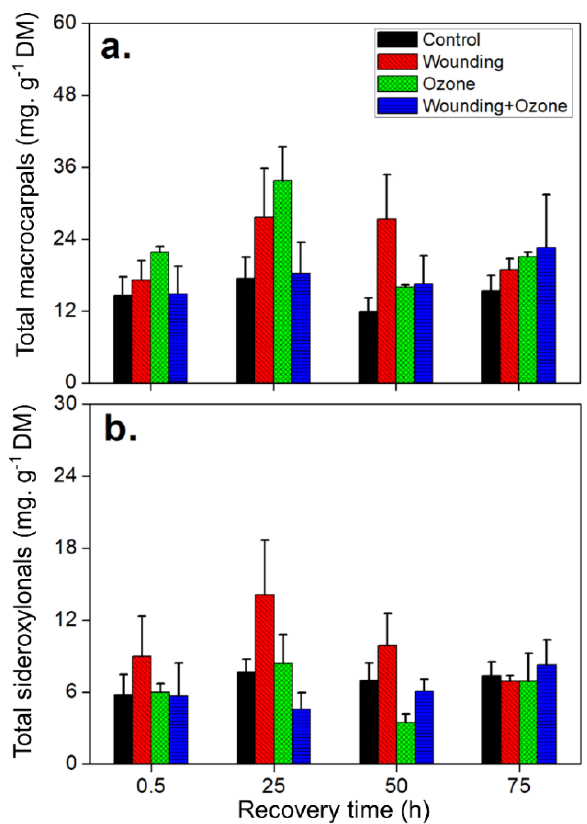
Figure 5. Time-dependent changes (means ± SE, n = 3) in the concentration of total macrocarpals ( a ) and total sideroxylonals ( b ) in E. globulus leaves subjected to separate and combined wounding and O 3 treatments. Details of the statistical summary are shown in Table 3. Total macrocarpals are expressed as mg g − 1 DM macrocarpal A equivalents, and total sideroxylonals are expressed as mg g − 1 DM sideroxylonal A equivalents.